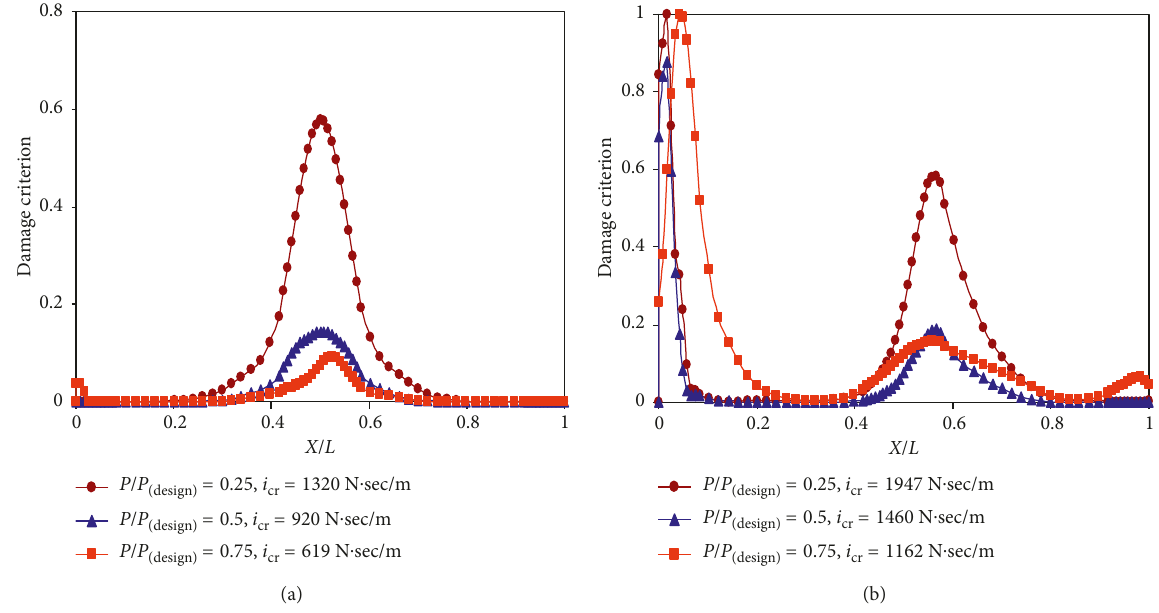
Figure 18: Damage initiation criterion profile of propped cantilever column W200 of the tension flange; (b) at the middle of the